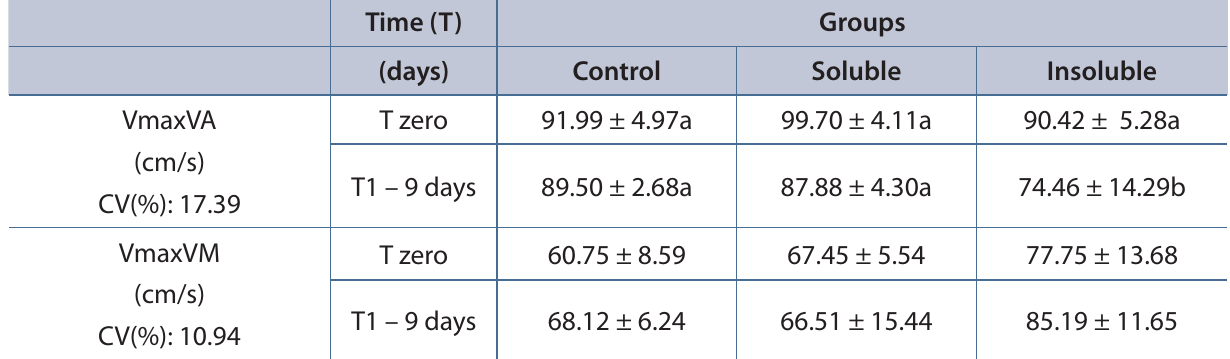
Table 8. Mean maximum flow velocities in aortic valve (VmaxVA - cm/s) and mitral valve* (VmaxVM - cm/s) in rabbits submitted to gavage procedure with ultra-pure water (CG), water-soluble A. rigida extract (SG) and water-insoluble A. rigida extract (IG) at different times